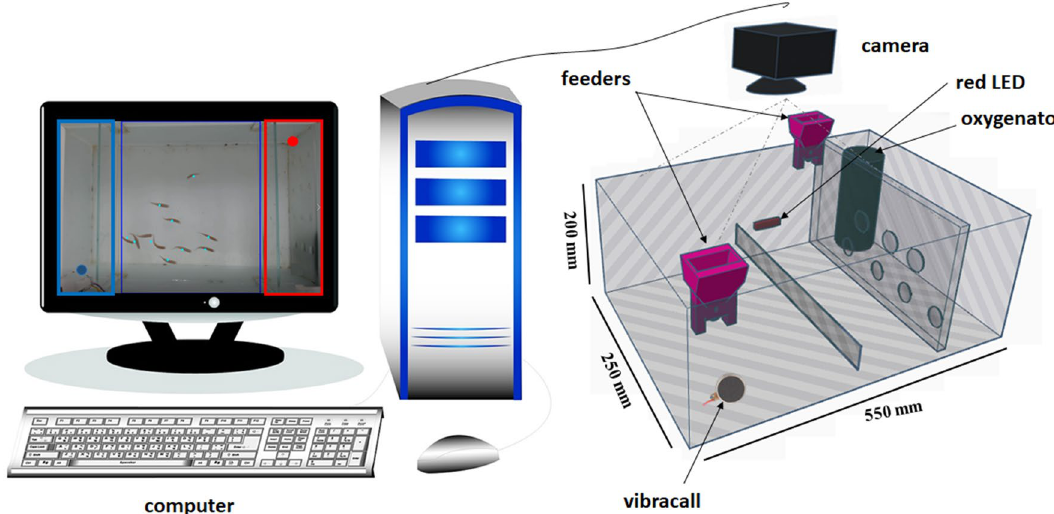
Figure 1. Experimental configuration to measure zebrafish learning. The group of zebrafish swims in a sandblasted glass tank, divided into two feeding arenas. A red LED strip is attached to the external area on the right side of the tank as a light stimulus. And a vibracall was attached to the external area on the left side of the tank. A camera is mounted above the tank, approximately 40